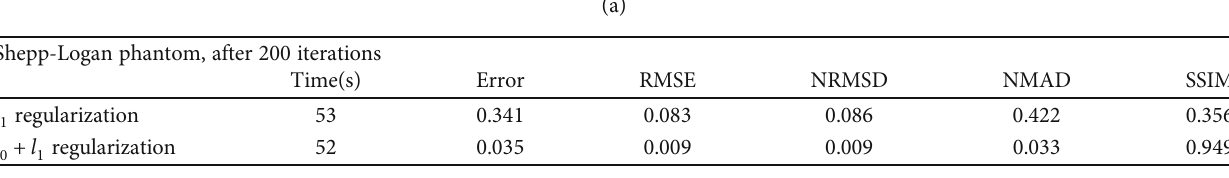
Table 1: Comparison of two algorithms after same number of iterations.